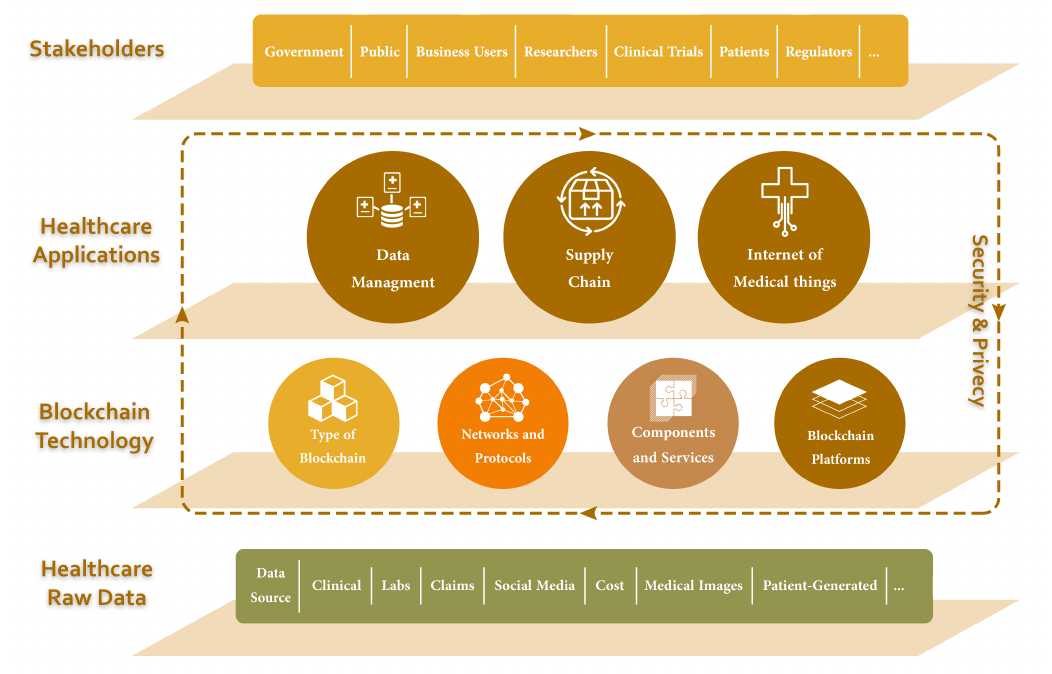
Figure 1. A workflow of blockchain-based healthcare applications. The workflow is composed of four main layers including healthcare raw data, blockchain technology, healthcare application, and stakeholders. The blockchain as a decentralized technology enables multiple stakeholders to benefit from healthcare